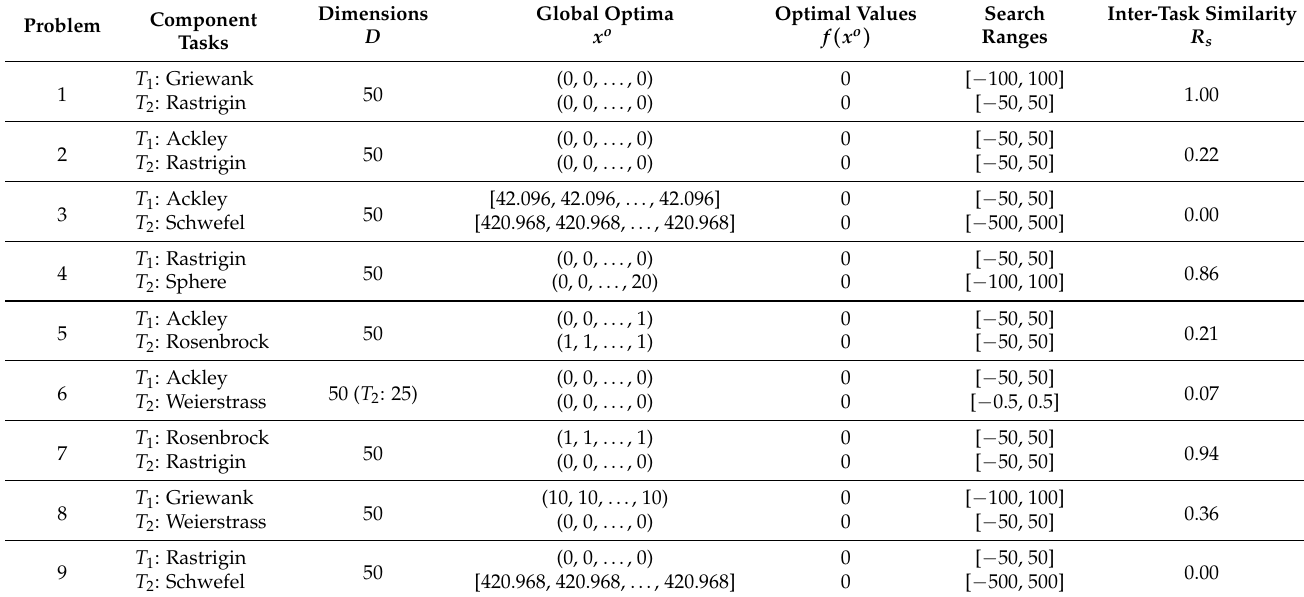
Table 1. Details of the 9 test problems in test suite I.